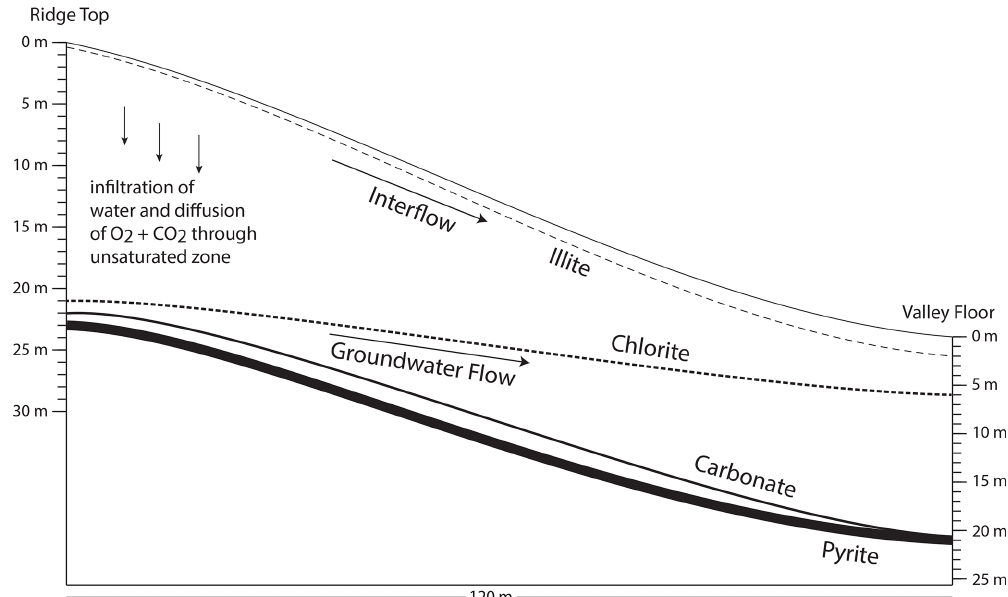
Figure 3. Schematic cross section of Shale Hills showing the depths (labeled lines) where oxidation of pyrite and dissolution of carbonate, chlorite, and illite initiate (modified after Brantley et al., 2013a). Illite and chlorite dissolve at all depths above the labeled lines, but reactions of carbonate minerals and pyrite only occur in a narrow 1m wide depth zone under the ridge that widens to several meters toward the valley. Specifically, pyrite oxidation is complete under both ridge and valley at the depths where chlorite dissolution initiates. Carbonate dissolution is complete at the depth where pyrite oxidation is complete under the ridge but at ∼ 4m above the pyrite front under the valley. These reaction fronts are estimated and extrapolated from bulk chemistry measured in samples from boreholes located at the ridge and valley (Jin et al., 2010; Brantley et al., 2013a; Gu et al.,